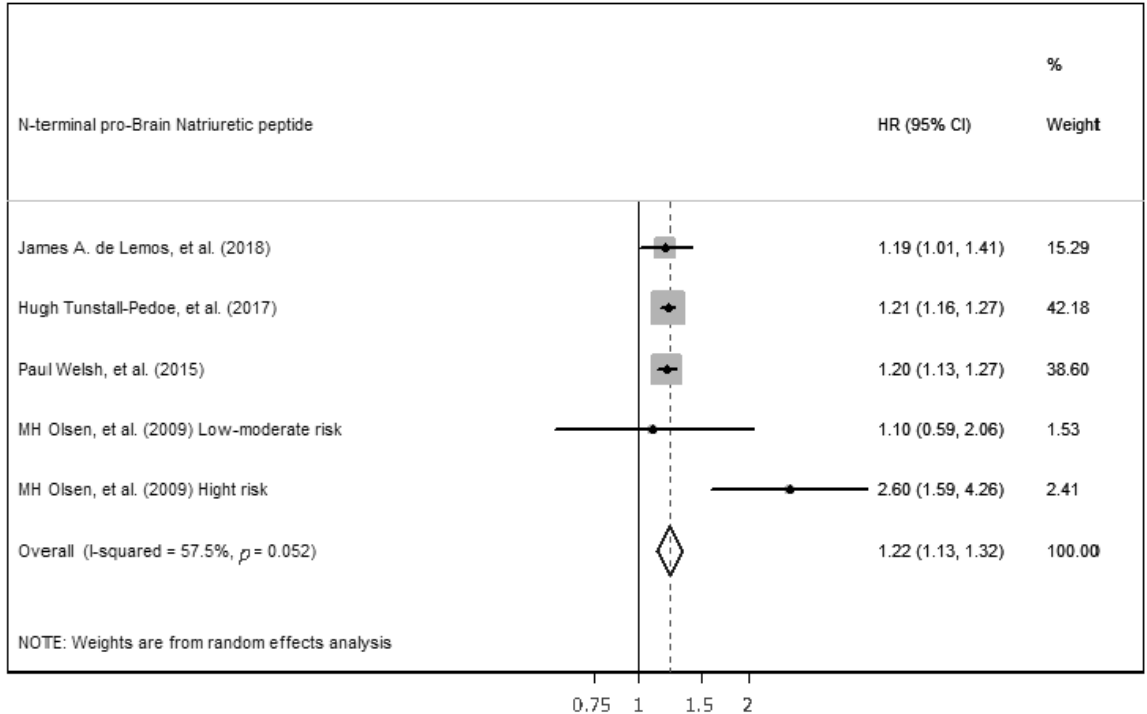
Figure 4. Forest plot of studies for NT-proBNP prediction of CVD among middle-aged adults with- out a prior CVD history or symptom [19,20,29,39]. a prior CVD history or symptom